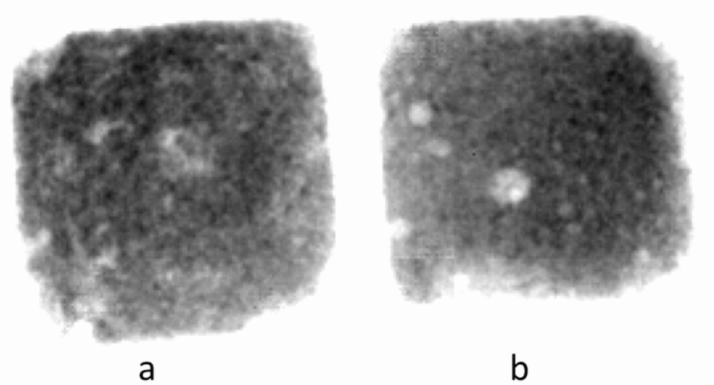
Figure 5. Radiographic images of bio-mortars realized with 10% of primal ( a ) and 10% of OFI ( b ) showing in white the porosity.